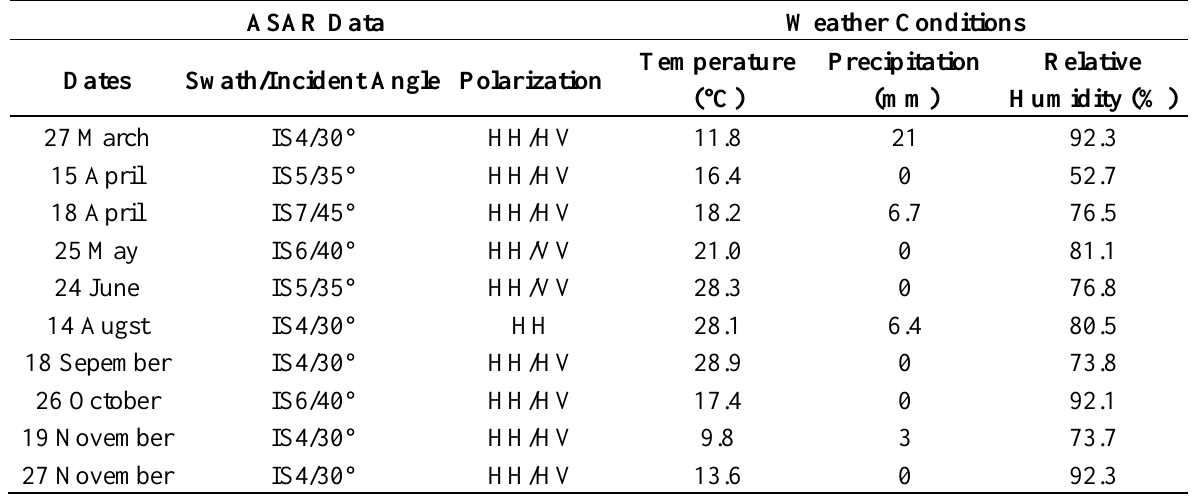
Table 2. ENVISAT/ASAR data and weather conditions data collected in